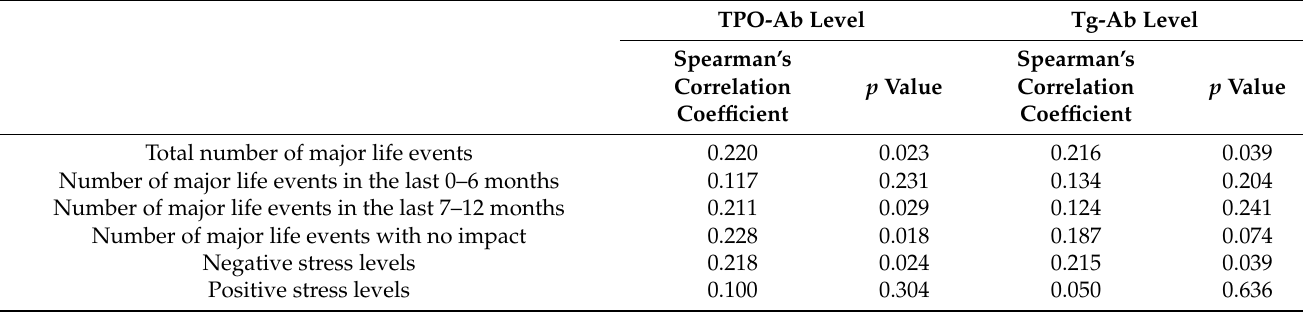
Figure 2. Correlations between selected cytokines and stressful life events in the HT and control groups: ( a ) Correlation between IL-22 and stressful life events occurring 7–12 months before HT diagnosis. ( b ) Correlation between positive stress levels and IL-13 in the control group. ( c ) Correlation between positive stress levels and IL-5 in the control group. Table 3. Correlations between various stress parameters and TPO-Ab and Tg-Ab.